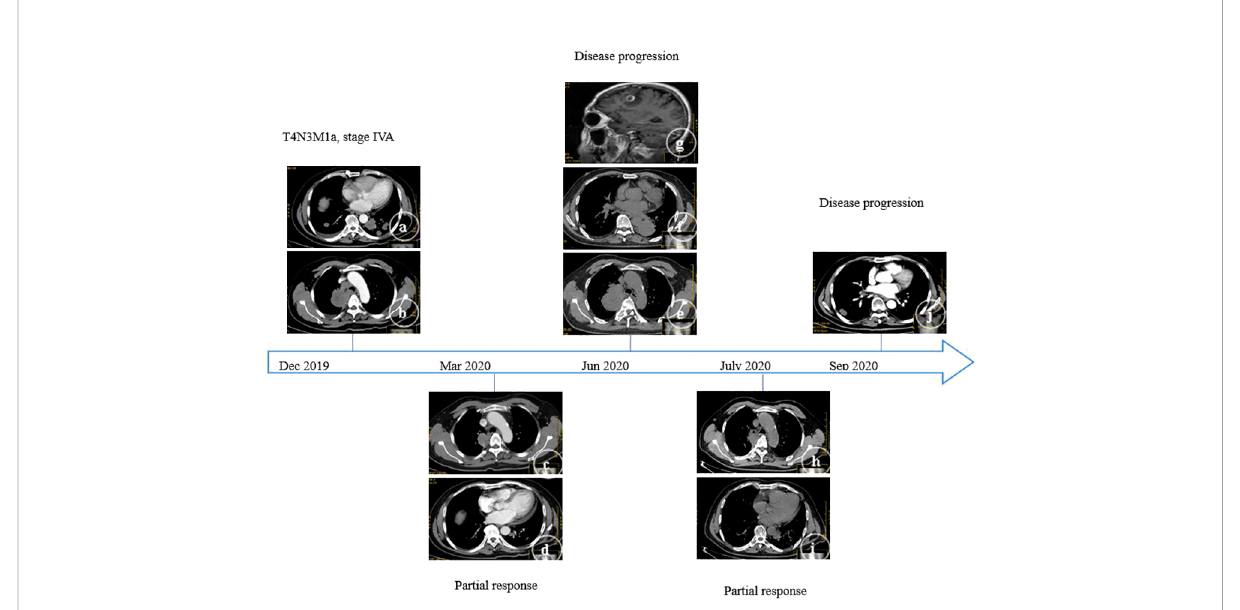
FIGURE 1 A series of CT fi ndings during the clinical course. On admission, a primary lesion (A) in the right upper lobe of the lung and multiple metastases (B) in the left lower lobe of the lung were identi fi ed. Treatment with icotinib was performed, and after three months, partial remission was found (right, C ; left, D ). Treatment with icotinib was performed, and after six months, progressive disease was found (right, E ; left, F ; brain MRI, G ). Treatment with osimertinib was performed, and after one month, partial remission was found (right, H ; left, I ). Treatment with osimertinib was performed, and after three months, progressive disease was found (right, J